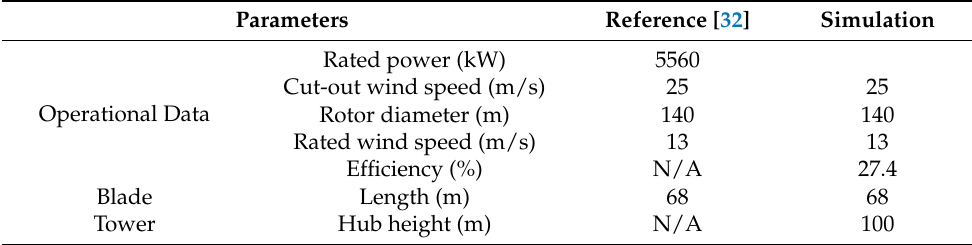
Table 4. Design specifications of the wind turbine.